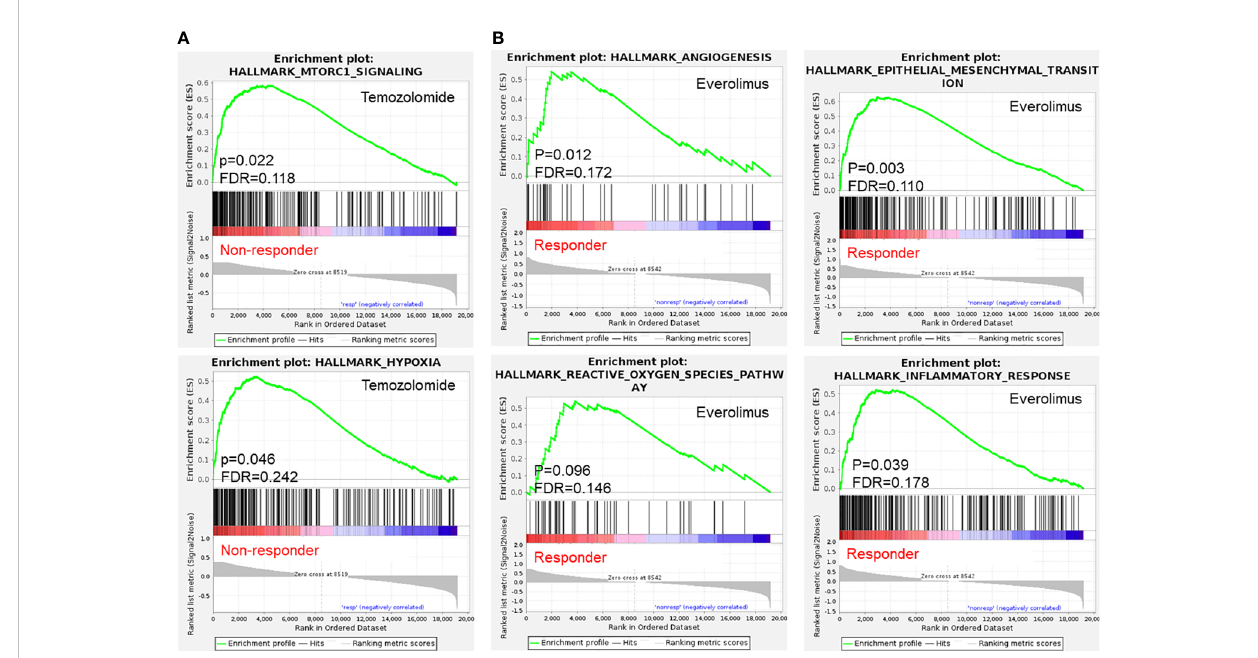
FIGURE 5 Selected gene set enrichment analysis plots of s.c. PDX tumor tissue based on results in chemosensitivity testing. (A) Enriched hallmark gene sets (p < 0.1 and FDR < 25%) in temozolomide resistant PDX and (B) PDX responding to mTOR inhibitor everolimus indicate possible implications of mTOR signaling and hypoxia for the monitored